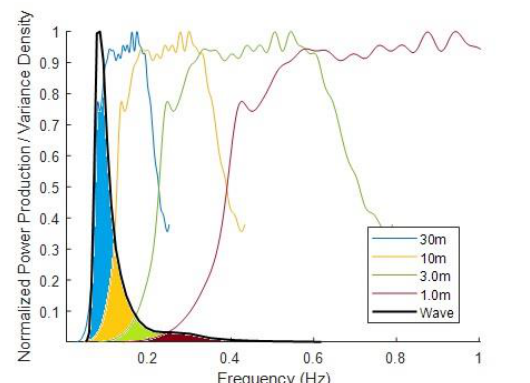
Figure 8: Impact of frequency domain response of WEC size with respect to wave spectra. The second y-axis is the WEC CWR.